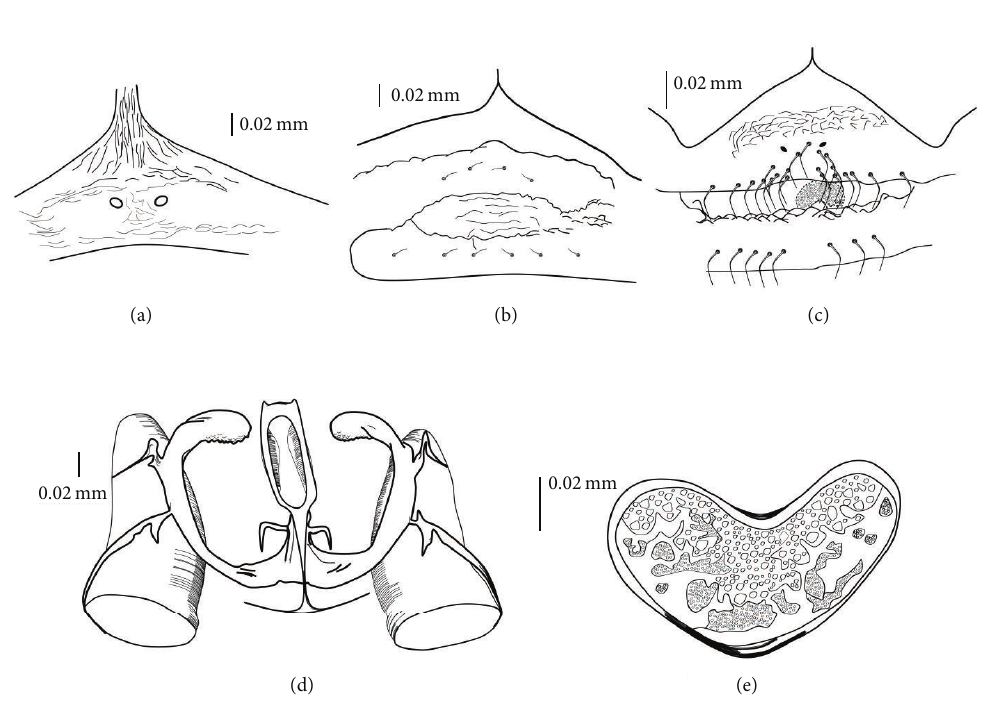
Figure 11: The genital organs of Dactylochelifer gracilis : (a) anterior operculum of deutonymph, (b) anterior and posterior operculum of tritonymph, (c) anterior and posterior operculum of female, (d) genital organs of male, and (e) cribriform